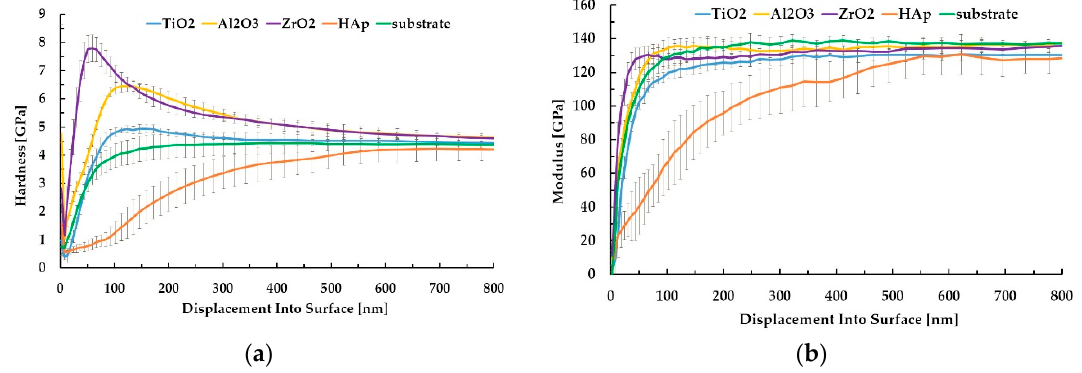
Figure 9. Hardness ( a ) and elastic modulus ( b ) depth profiles for investigated samples.